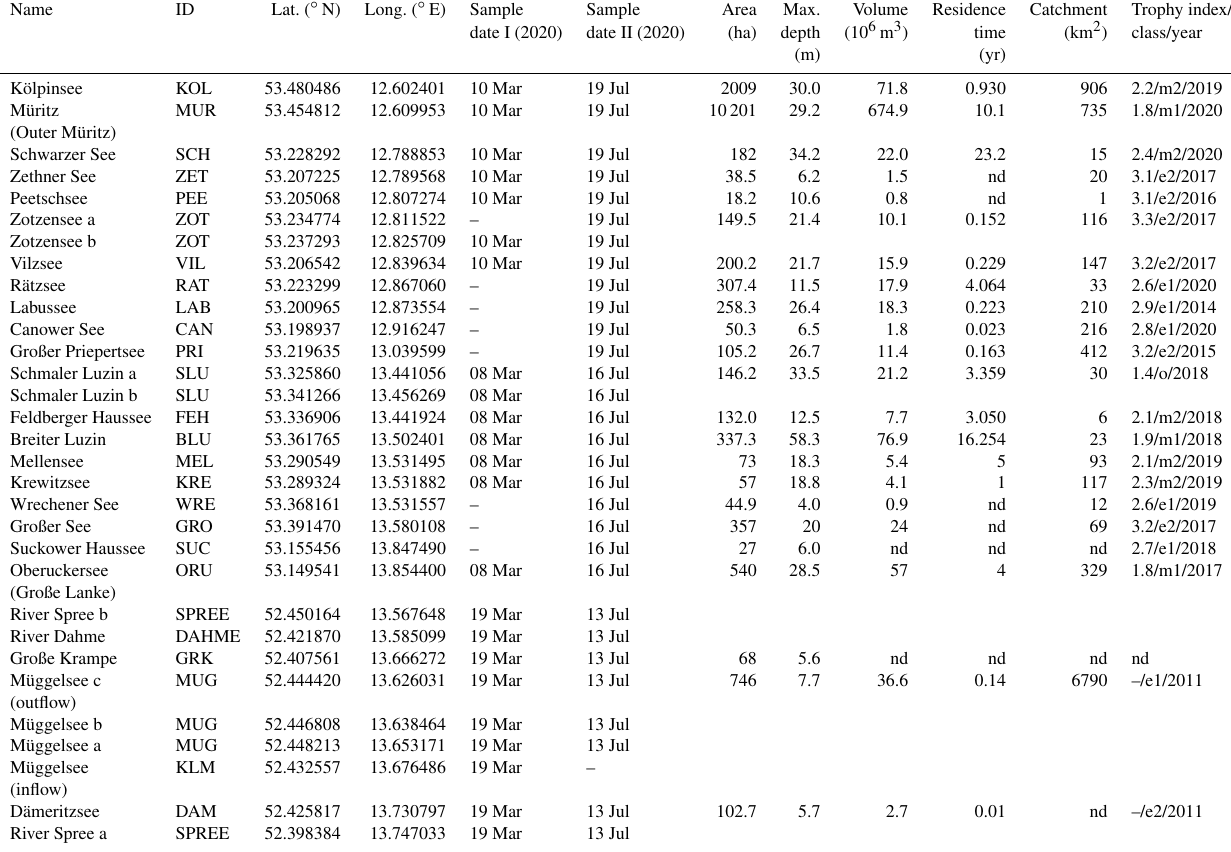
Table 1. Parameters of lakes with shore sampling spots (yellow dots in Fig. 1). Samples taken 40–60cm below the water surface. Trophy class according to LAWA (2014) with the year of the most recent evaluation. Data from the respective German states were provided by local authorities (Landesamt für Umwelt Brandenburg, the Ministry of Agriculture and Environment Mecklenburg-Vorpommern); nd: no